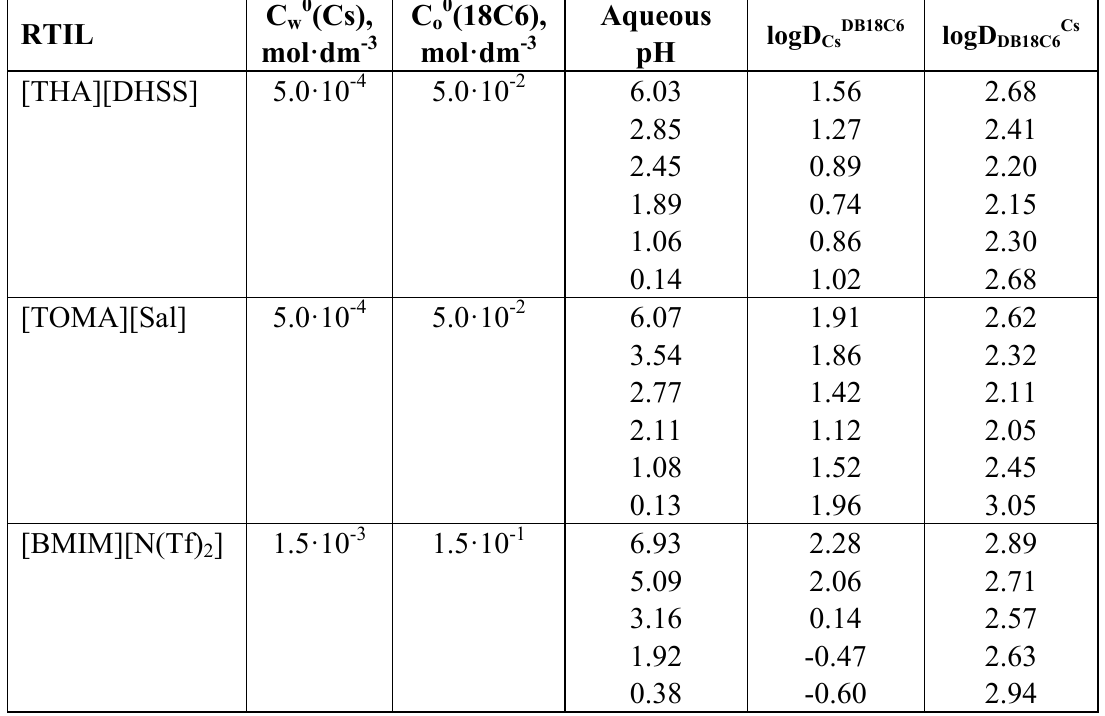
= 0.5 mL; V = 5.0 o w